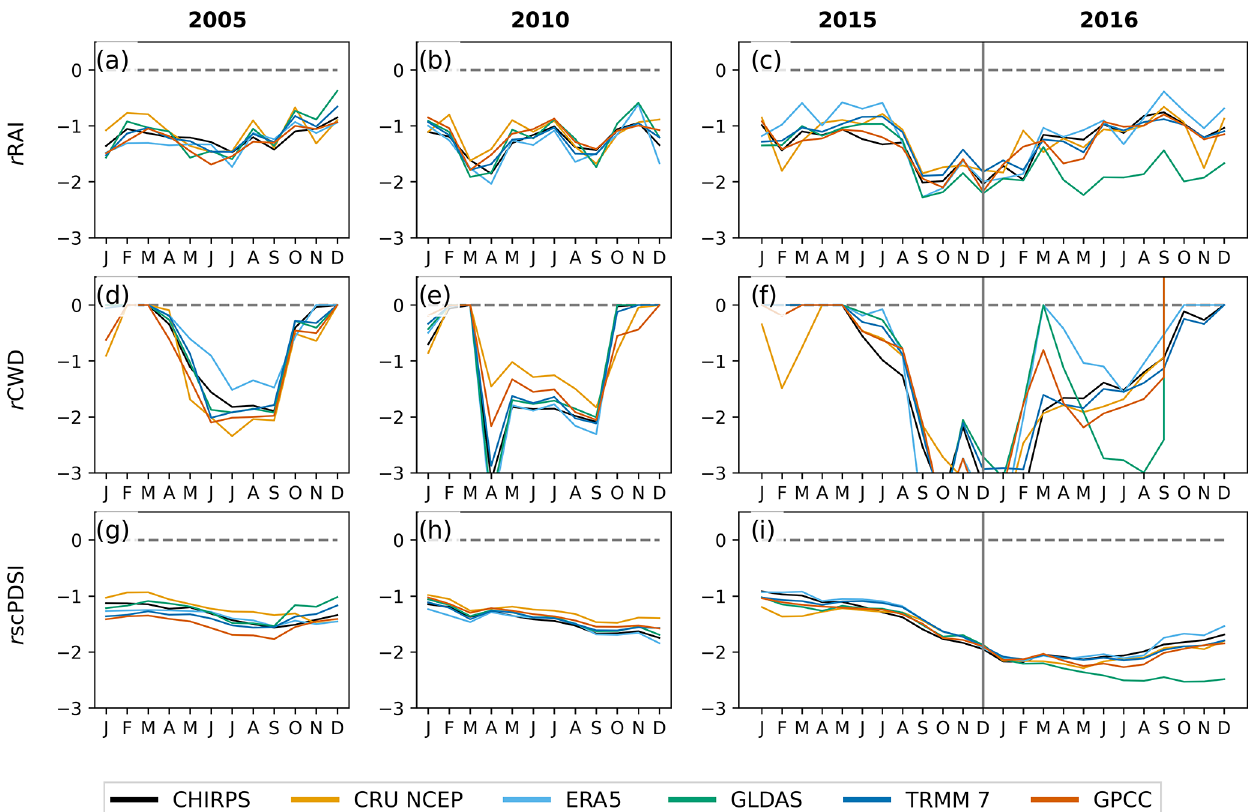
Figure 6. Monthly development of the Amazon drought events in 2005, 2010 and 2016 (columns) as described by the three different drought indices (rows): (a–c) rMCWD, (d–f) rscPDSI and (g–i) relative rainfall anomaly (rRAI). Coloured lines indicate the indices of the 10th percentile of all grid cells of each of the different precipitation datasets. The indices are estimated as the relative deviation from a 2001 to 2016 baseline period for each